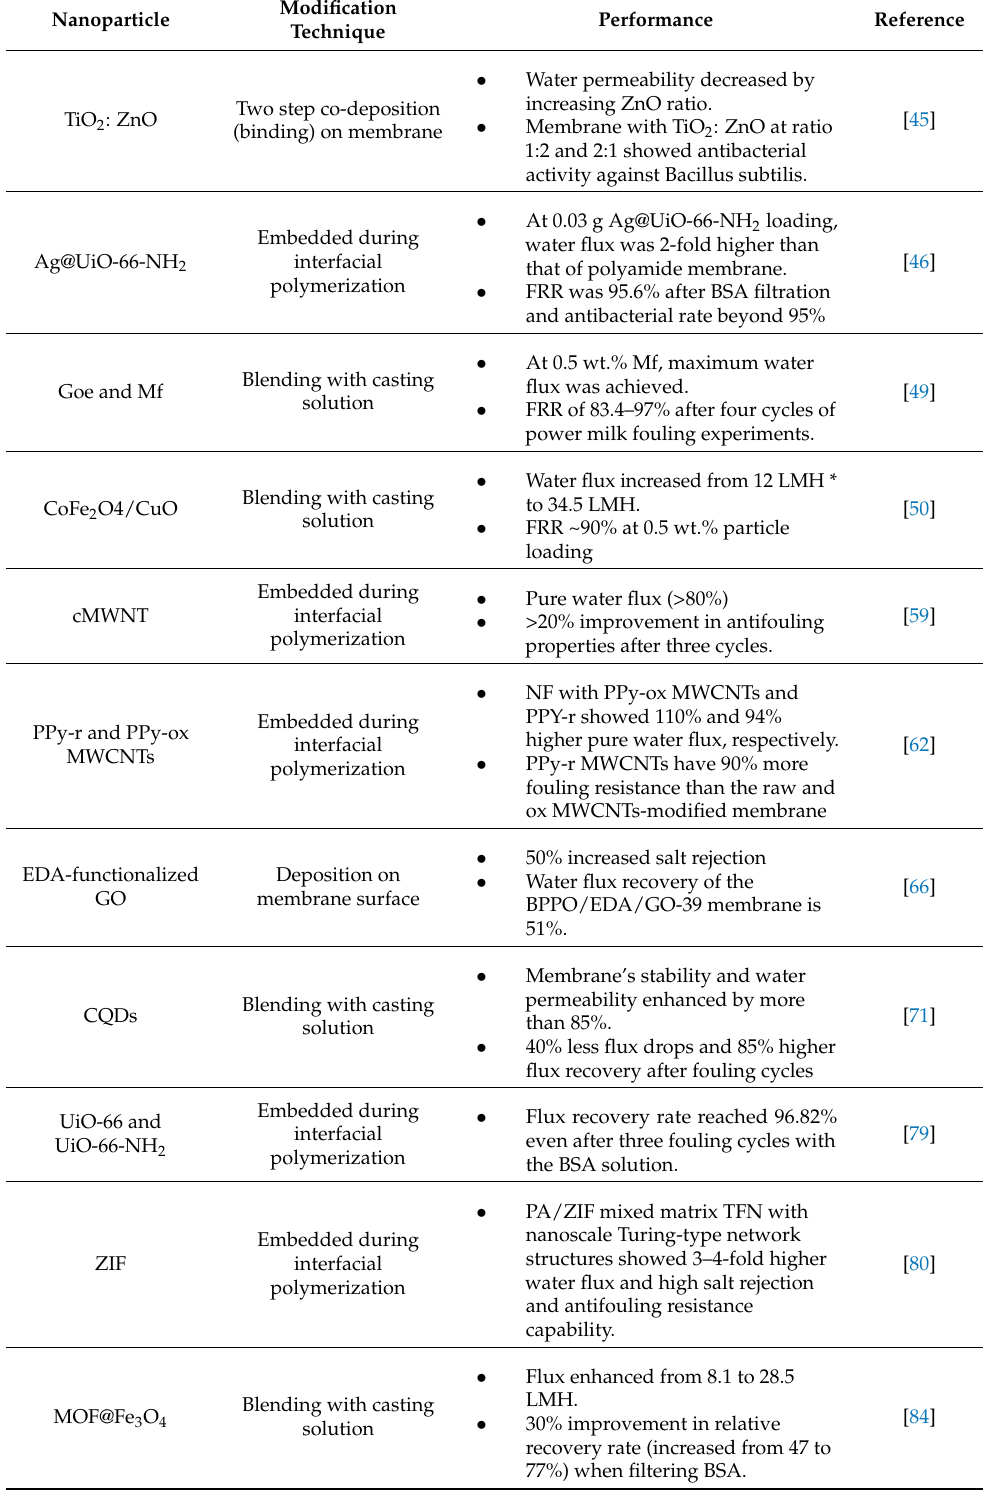
Table 1. NF modification using various types of